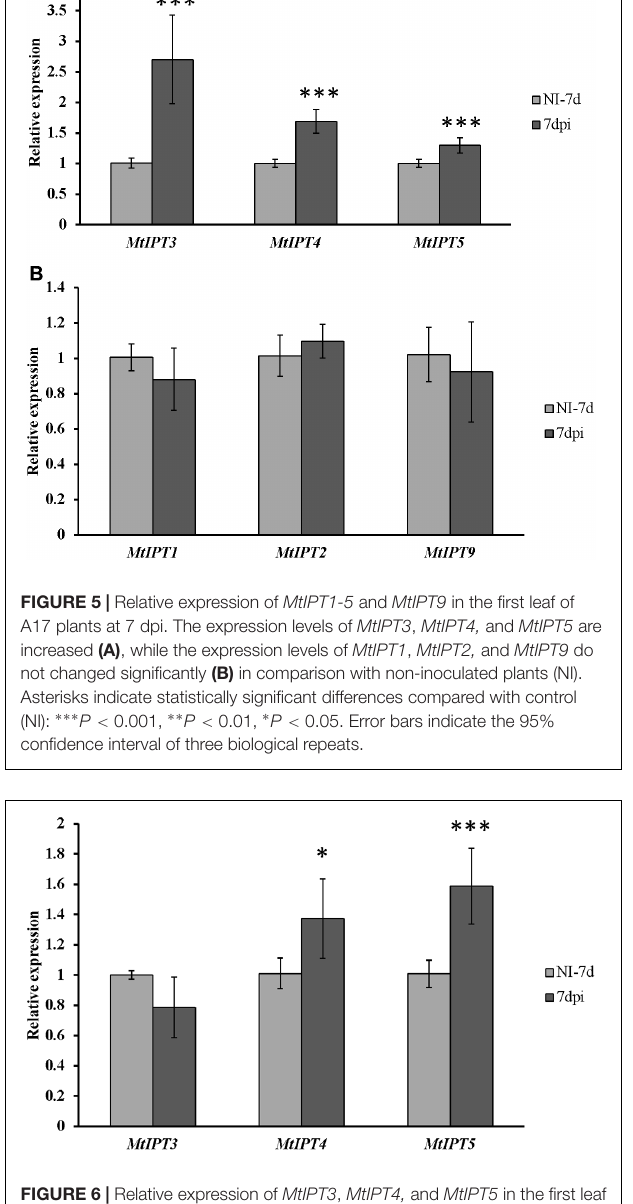
FIGURE 6 | Relative expression of MtIPT3 , MtIPT4, and MtIPT5 in the first leaf of sunn-3 mutant at 7 dpi in comparison with non-inoculated plants (NI). Asterisks indicate statistically significant differences compared with control (NI): ∗∗∗ P < 0.001, ∗∗ P < 0.01, ∗ P < 0.05. Error bars indicate the 95% confidence interval of three biological